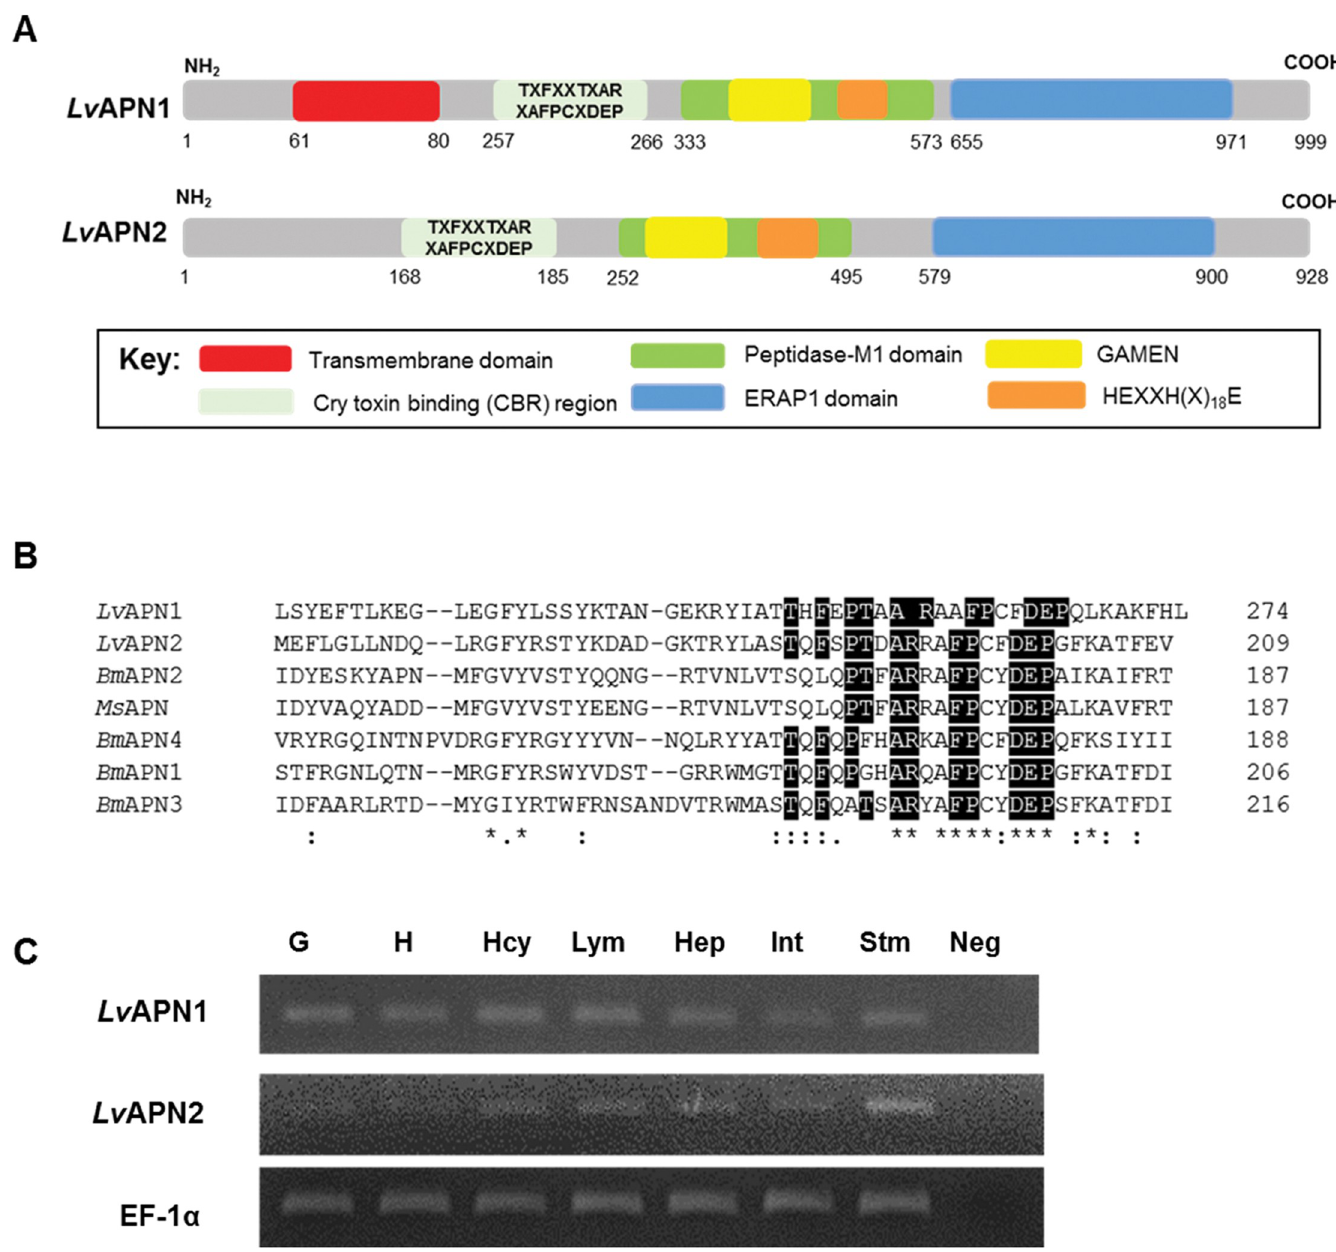
Fig 1. Lv APN1 characteristics analysis. (A) Schematic presentation of specific motifs and other components in the Lv APN sequence. Predicted positions of the putative N-terminal transmembrane domain, Cry-binding region (CBR), peptidase-M1 domain, and the GAMEN and HEXXH(X) 18 E zinc-binding site motifs are shown in red, grey, green, yellow, blue and orange, respectively. (B) Alignment of the Cry1Aa toxin-binding region (CBR) of Litopenaeus vannamei , Bombyx mori and Manduca sexta APNs. The sequences of Lv APN1 (XP_027215499.1); Lv APN2 (XP_027218958.1); Bm APN1 (AFK85020); Bm APN2 (AB011497); Bm APN3 (AF352574); Bm APN4 (AB013400) and Ms APN (CAA66466) were compared. Perfectly conserved amino acid residues have black backgrounds. (C) Aminopeptidase N transcript expression analysis in various L . vannamei tissues by RT-PCR. The tissues examined were gill (G), heart (H), hemocyte (Hcy), lymphoid (Lym), hepatopancreas (Hep), intestine (Int) and stomach (Stm). EF1- α was used as the internal reference and PCR control. Neg is a negative control. A representative data of 3 biological replicates is